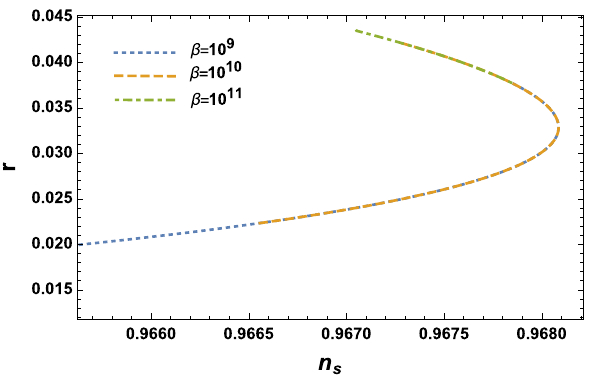
Fig. 11 n s vs r for φ 0 intheinterval3 × 10 − 4 M p ≤ φ 0 ≤ 3 × 10 − 3 M p for N = 60, η = 0 . 25 and β = 10 9 , 10 10 , 10 11 . All curves follow the same trajectory but start at different points depending on